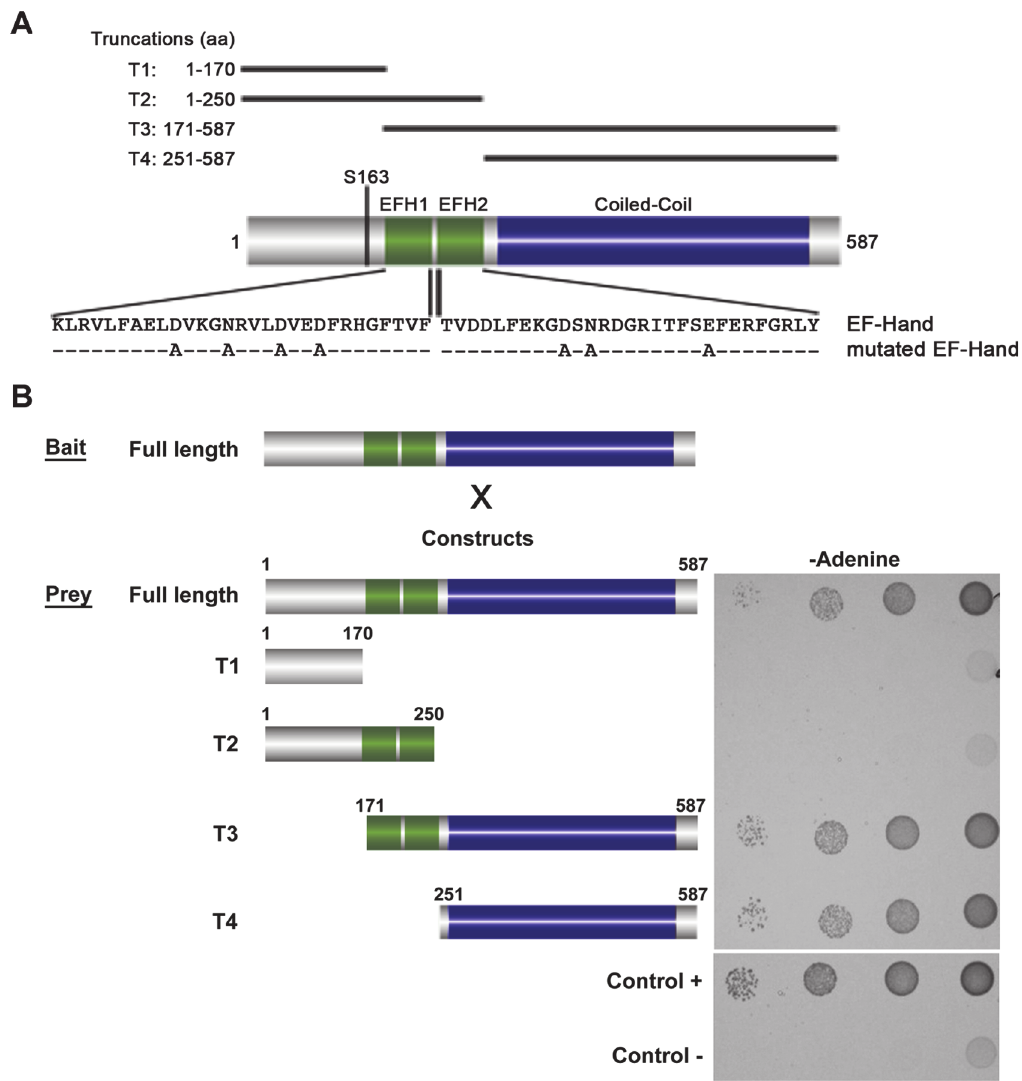
Fig 1. Schematic diagram of BILBO1 primary structure and yeast two-hybrid identification of its interaction domains. (A) BILBO1 has two predicted EF-hand calcium-binding domain EFH1 and EFH2, from amino acids Lysine 185 to Tyrosine 249, and a long domain predicted as coiled-coil. Serine 163 is phosphorylated in vivo . The main truncations used in this study are shown schematically and labelled as T1-T4. The mutations in the EF-hand calcium binding domains are indicated below the wild-type amino acid sequence. (B) Bait (BILBO1 full-length) and prey interactions were tested by drop tests on adenine-free selective medium. Full-length BILBO1 interacts with full-length BILBO1, whilst truncations T1 and T2 do not interact with full-length BILBO1. T3 and T4 truncations interactions were positive, demonstrating that the coiled-coil domain is required for BILBO1-BILBO1 interaction.